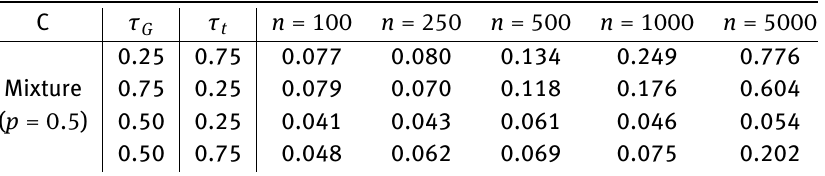
Table 9: d = 2 : Empirical power of the test for ellipticity with significance level α = 0.05 based on the test statistic T n : rate of rejecting H 0 as observed in 1000 random samples of size n from a mixture C of bivariate elliptical copulas with Kendall’s tau combinations ( τ G , τ t )